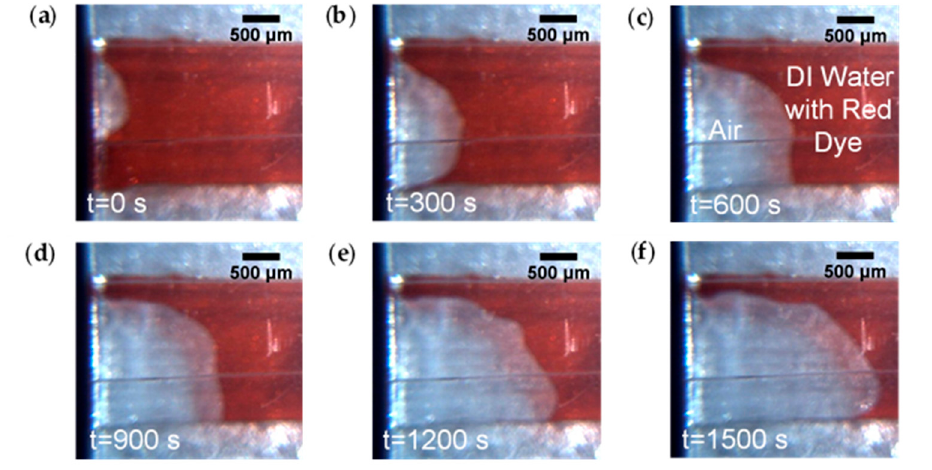
Figure 5. Electroosmotic pumping on the continuous microfluidic channel using membrane